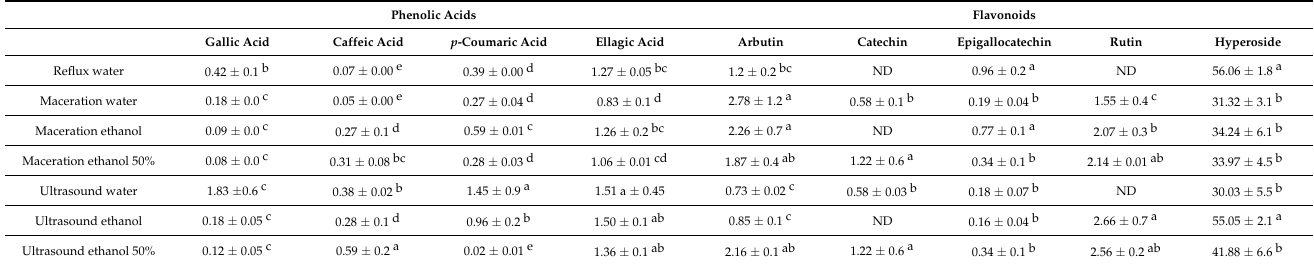
Table 3. Identification and quantification (mg/g DR) of the main polyphenols present in A. unedo extracts (mean ± standard deviation, n = 3).